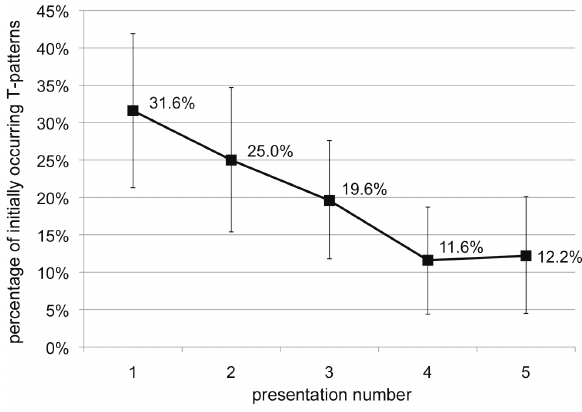
Figure 6. Emergence rates of new T-patterns in stimulus presentations 1 to 5 (means and 95% confidence intervals)